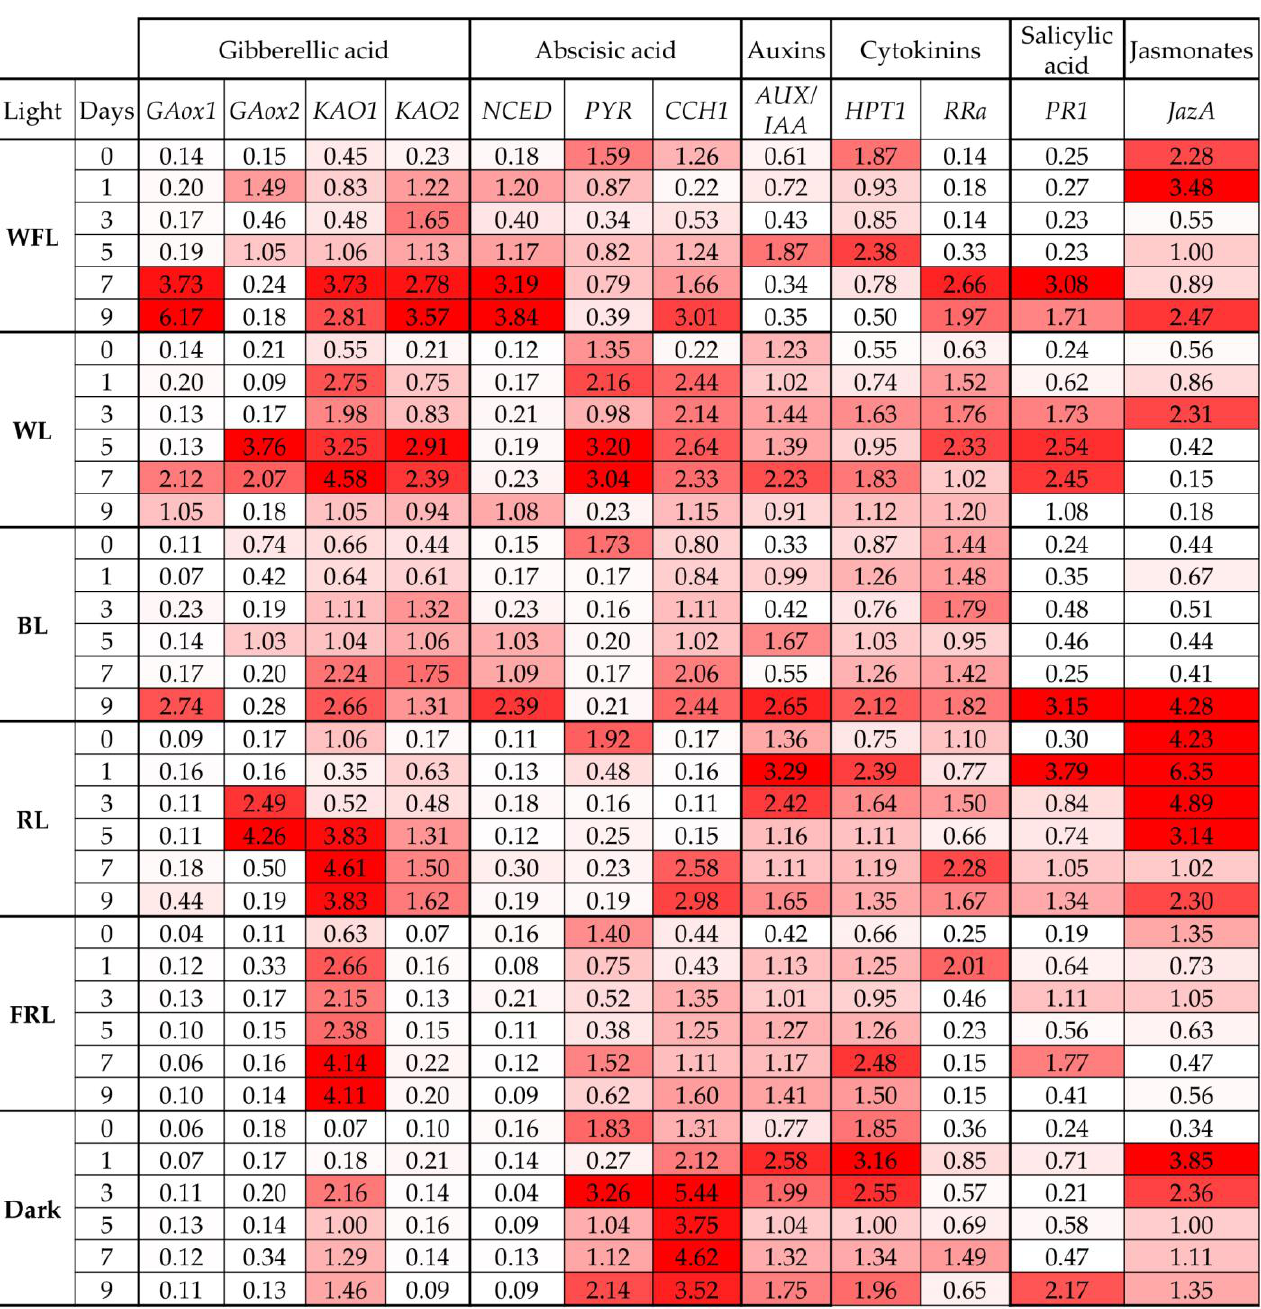
Figure 6. Transcript levels of genes of gibberellic acid biosynthesis and signaling ( GA3ox1, GA3ox2, KAO1, KAO2 ), as well as ABA biosynthesis and signaling ( NCED, PYR, CCH1 ), main genes of auxin signaling ( AUX/IAA ), cytokinin signaling ( HPT1, RRa ), salicylic acid signaling ( PR1 ) jasmonic acid signaling ( JAZa ), in Scots pine plantlets under different light quality and dark conditions on days 0, 1, 3, 5, 7 and 9 of the experiment. The color scale rules: increase in expression by at least two times (dark red light) relative to the average value of the expression of the specified gene in column. The maximum levels of the GA3ox2 gene transcripts were observed in plantlets grown under WL and RL. At the same time, under WFL and BL, there were two peaks in the content of the transcripts of this gene. In the dark and FRL, the content of GA3ox2 gene transcripts did not change (Figure